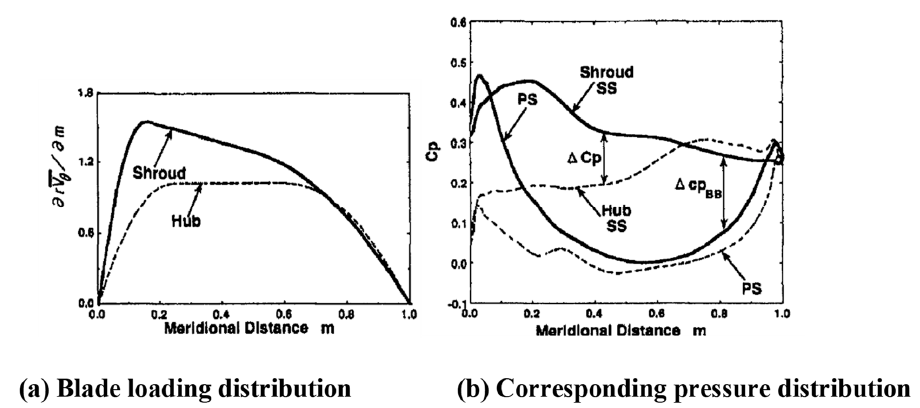
Figure 4. Calculated pressure coefficient Cp distribution on both the pressure surface and suction surface at the shroud and hub, respectively, for the conventional impeller [43].